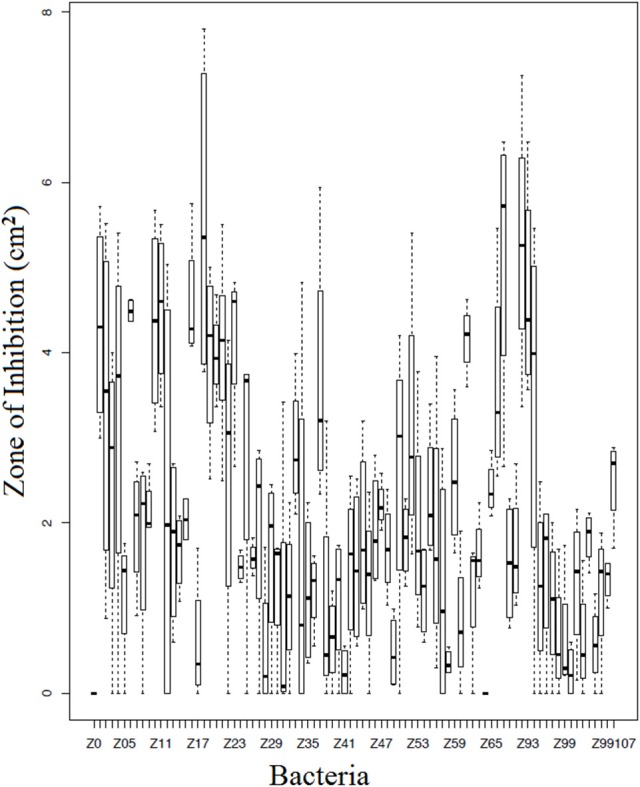
Box plot estimates of the agar based challenge assay for each of the bacteria strains. The box represents the interquartile range (IQR) and the top and bottom whiskers represent Q3—(1.5 IQR) and Q1—(1.5 IQR), respectively. Bacteria IDs on the x-axis are referenced in Supplementary Table 4. Larger values signify greater inhibition of Bd growth.